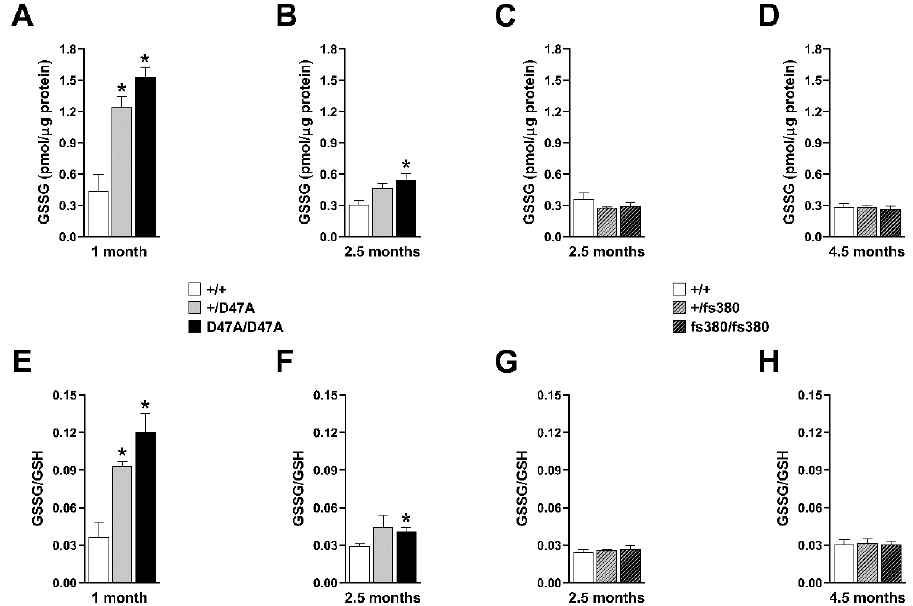
Figure 4. GSSG levels and GSSG / GSH ratio in whole lenses from Cx50D47A and Cx46fs380 mice. ( A , B , E , F ) Graphs show the levels of GSSG ( A , B ) and the GSSG / GSH ratio ( E , F ) in lenses from 1- ( A , E ) and 2.5- ( B , F ) month-old mice that were wild type for Cx50 ( +/+ ), and heterozygous ( +/ D47A) and homozygous (D47A / D47A) for Cx50D47A. ( C , D , G , H ) Graphs show the levels of GSSG ( C , D ) and GSSG / GSH ratio ( G , H ) in lenses from 2.5- ( C , G ) and 4.5- ( D , H ) month-old wild-type ( +/+ ) and heterozygous ( +/ fs380) and homozygous (fs380 / fs380) Cx46fs380 mice. Data are presented as the mean (bar) + standard error of the mean (n = 3 for 1-month-old and n = 4 for 2.5-month-old Cx50D47A mice; n = 3 for 2.5-month-old Cx46fs380 mice and n = 4 for 4.5-month-old Cx46fs380 mice). Asterisk denote a significant di ff erence compared with wild type ( p < 0.05). GSSG levels and the GSSG / GSH ratio were not significantly di ff erent between wild-type and 2.5-month-old heterozygous Cx50D47A lenses ( p = 0.09 and 0.24, respectively).